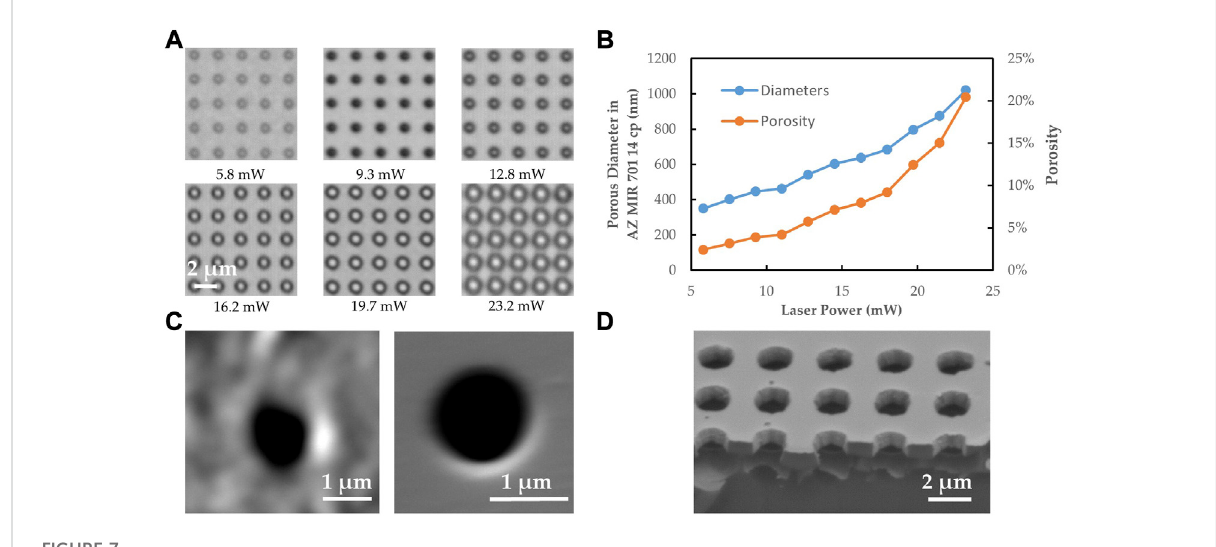
FIGURE 7 (A) Electron microscopy images with nanopore patterns in the developed photoresist in dependence of laser power. (B) The corresponding diametersandporositiesintheresultingnanoporousmembraneasobtainedfromelectronmicrographs. (C) SEMimagesofsinglenanoporesinSi x N y as obtained by ICP plasma etching and subsequent resist stripping. Left: At a laser power of 37.7 mW the photoresist was directly ablated. Right: At a lower laser power of 23.2 mW, the resist was only locally polymerized and developed afterwards. (D) SEM image of cleaved membrane (tilted by 45 °